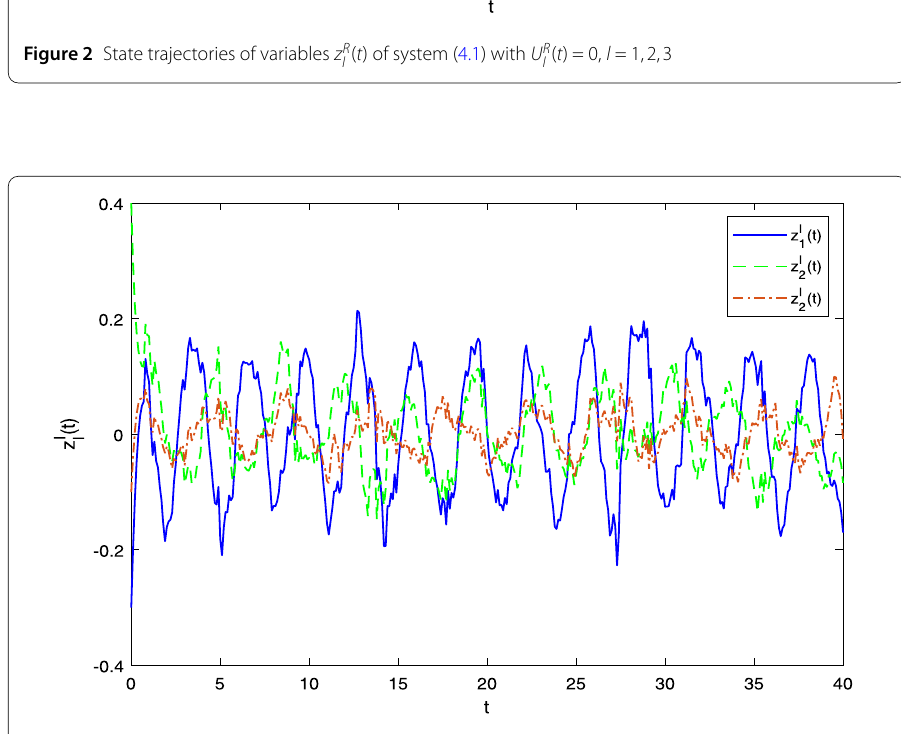
Figure 3 State trajectories of variables z I